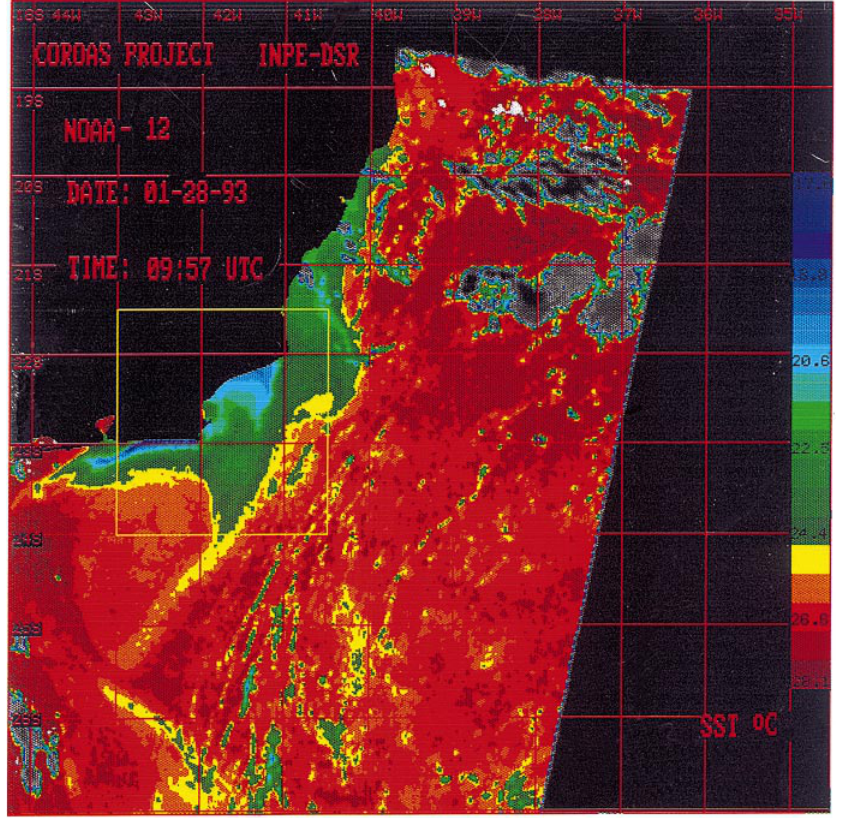
Fig. 2. Sea surface temperature satellite image showing the coastal upwelling in the Cabo Frio region. The yellow square repre- sents the